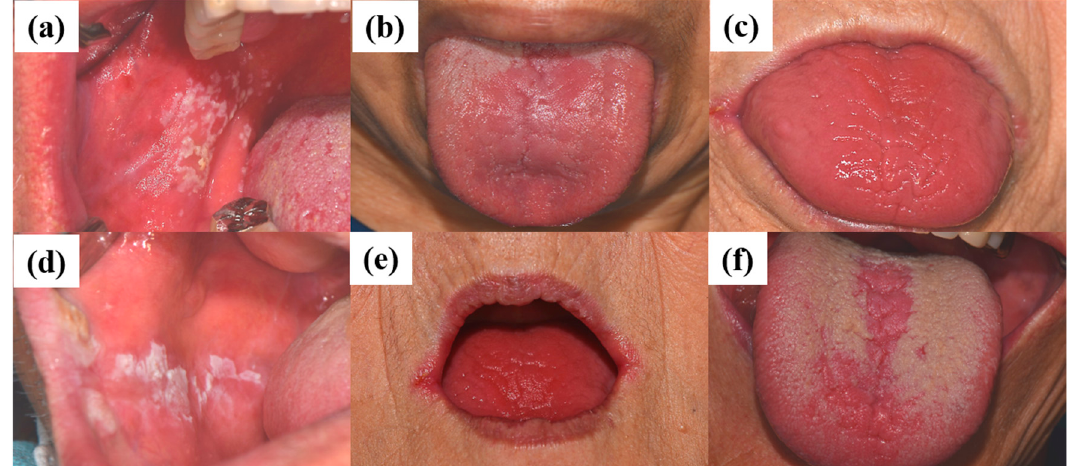
Figure 3. Clinical manifestations of oral candidiasis: ( a ) acute pseudomembranous candidiasis, ( b ) acute atrophic candidiasis, ( c ) chronic atrophic candidiasis, ( d ) chronic hyperplastic candidiasis, ( e ) angular cheilitis, and ( f ) median rhomboid glossitis. Clinical photographs were taken under patients’ informed-consent agreement, with approved Institutional Review Board, PNUDH-2017-026, from the Pusan National University Dental Hospital.